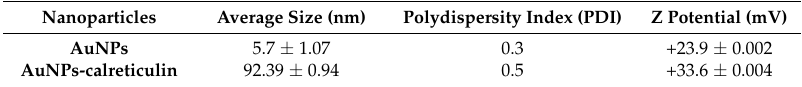
Table 1. Characteristics of AuNP and AuNPs–calreticulin obtained using chitosan as reducing agent. Measurements obtained at 25 ◦ C at pH in the range of